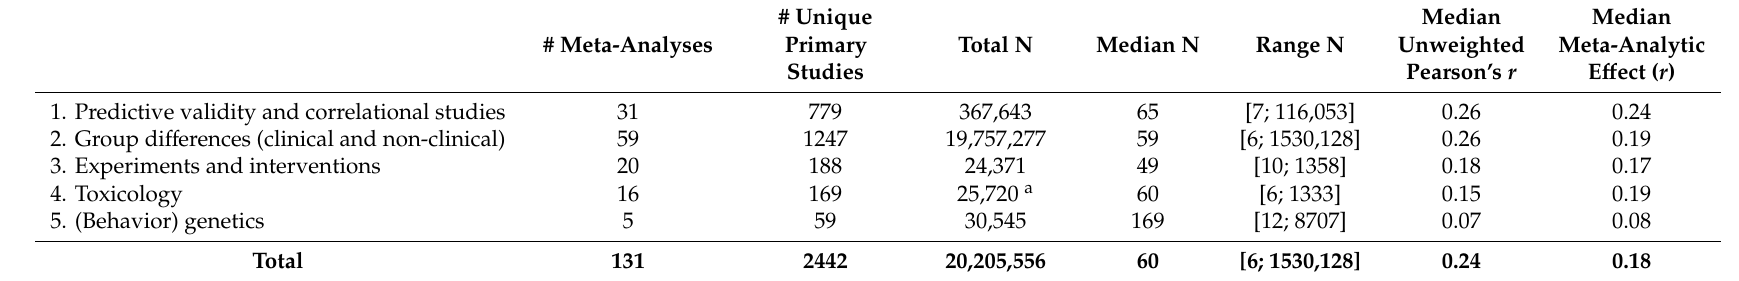
Table 2. Descriptive statistics of the primary studies split up into five types of studies and in